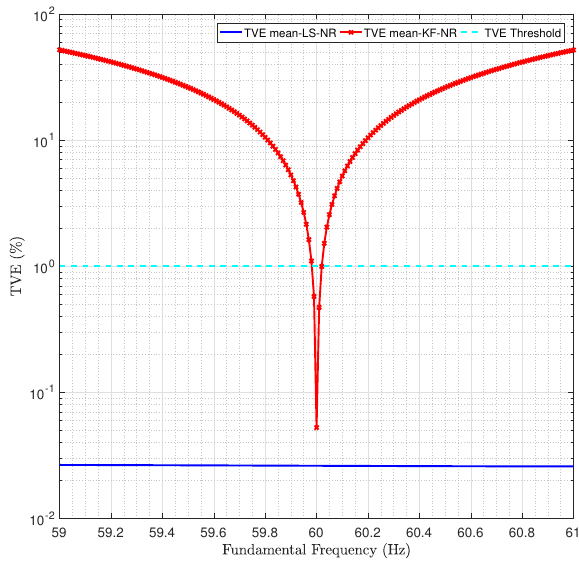
Figure 1. Mean TVE versus frequency deviation.